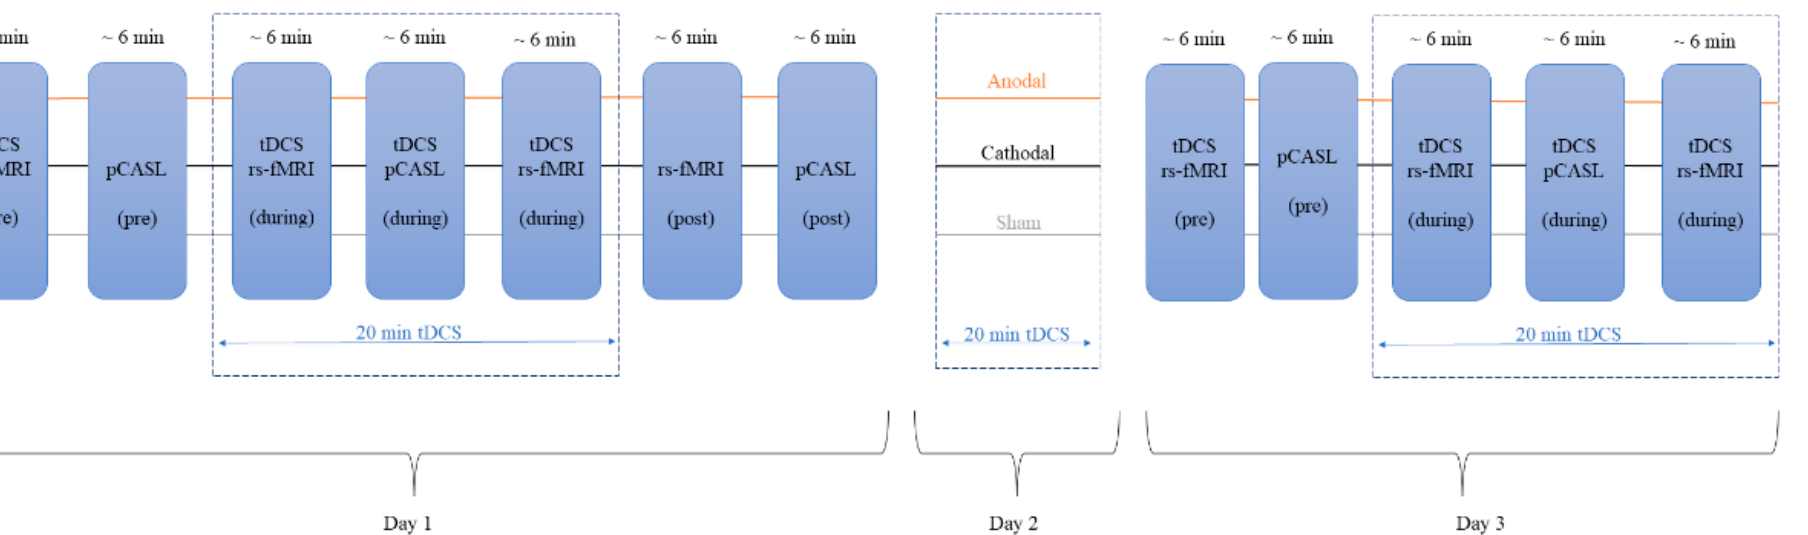
Figure 1. Experimental design: 20 min of anodal, cathodal, and sham tDCS was applied on 3 consecutive days. On day 1, pCASL sequences were collected before the tDCS (pCASL (pre)), during the tDCS (beginning ~6 min into the stimulation; tDCS pCASL (during)), and after the tDCS (pCASL (post)). On day 2, the participants received only the tDCS treatment, and no MRI data were acquired. On day 3, pCASL scans were acquired before the tDCS (pCASL (pre)), and during the tDCS (beginning ~6 min into the stimulation; tDCS pCASL (during)). rs-fMRI: resting-state fMRI; pCASL: pulsed continuous arterial spin labeling.